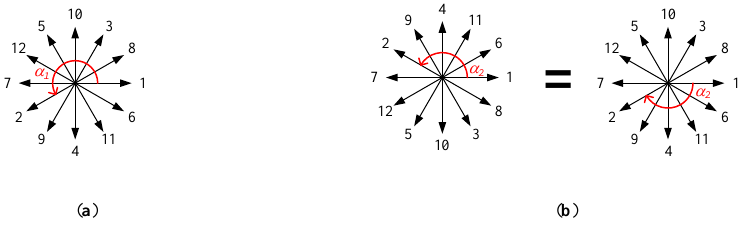
Figure 6. Armature back EMF vectors of the proposed machine with the rotating direction. ( a ) 𝛼 𝐴 = 𝛼 𝐵1 = 210 ∘ ; ( b ) 𝛼 𝐵2 = 150 ∘ .